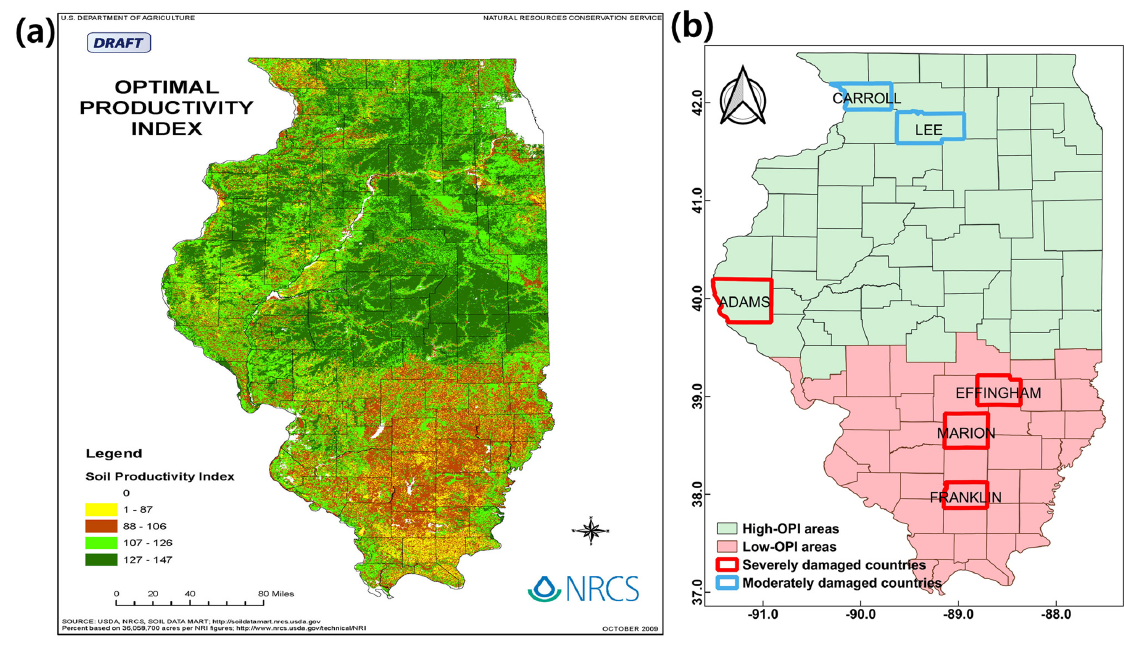
Figure 2. Map of ( a ) optimal productivity index (OPI) [77] and ( b ) the selected counties for drought analysis in Illinois.